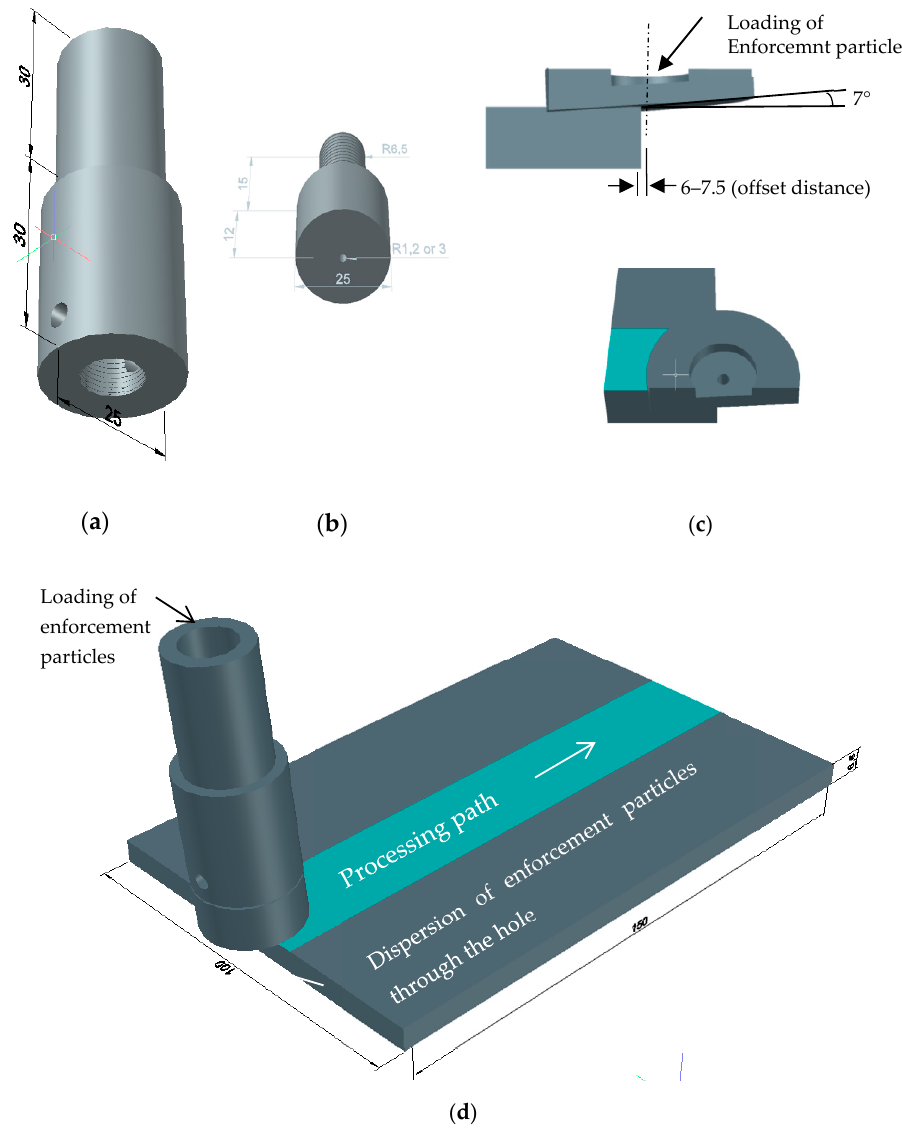
Figure 1. Schematic illustration of the FSP tool and design and processing procedures: ( a ) upper part, and ( b ) lower part of the FSP tool; ( c ) sectioned views of the tilting of tool head with respect to the processed aluminum plate; and ( d ) processing setup. All dimensions are in mm.